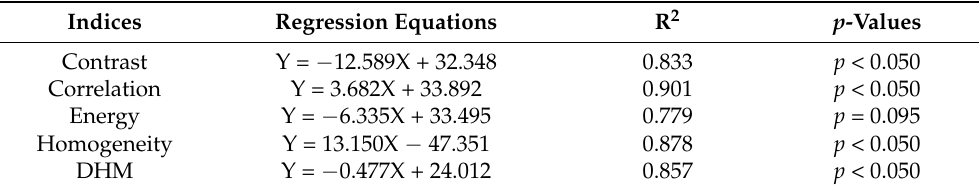
Table 5. The linear regression analysis of textural indices, DHM, and maize grain yields during the entire growth stages.